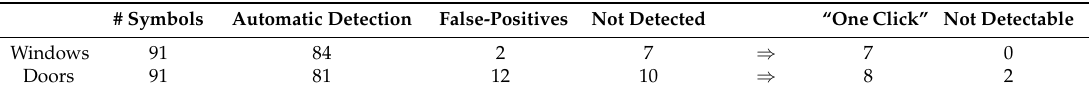
Table 4. Absolute Detection Values. With the automatic detection, 7 out of 10 symbols could not be detected. The “One-Click” approach could reduce these to only two not detectable symbols.